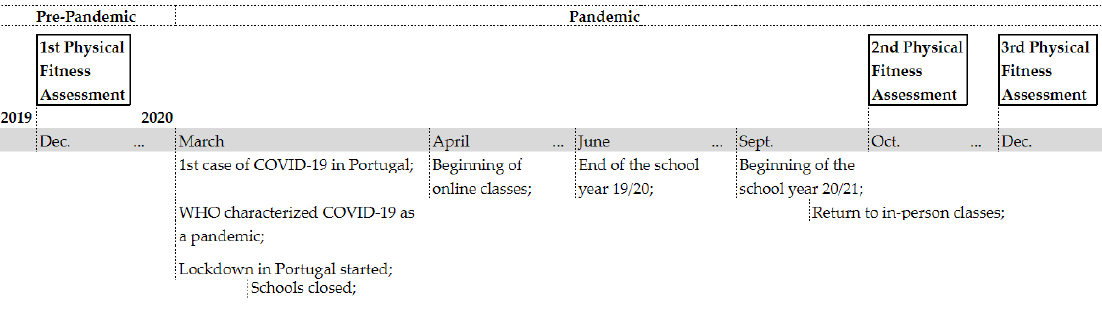
Figure 1. Physical fitness assessment timeline and COVID-19 regulations.